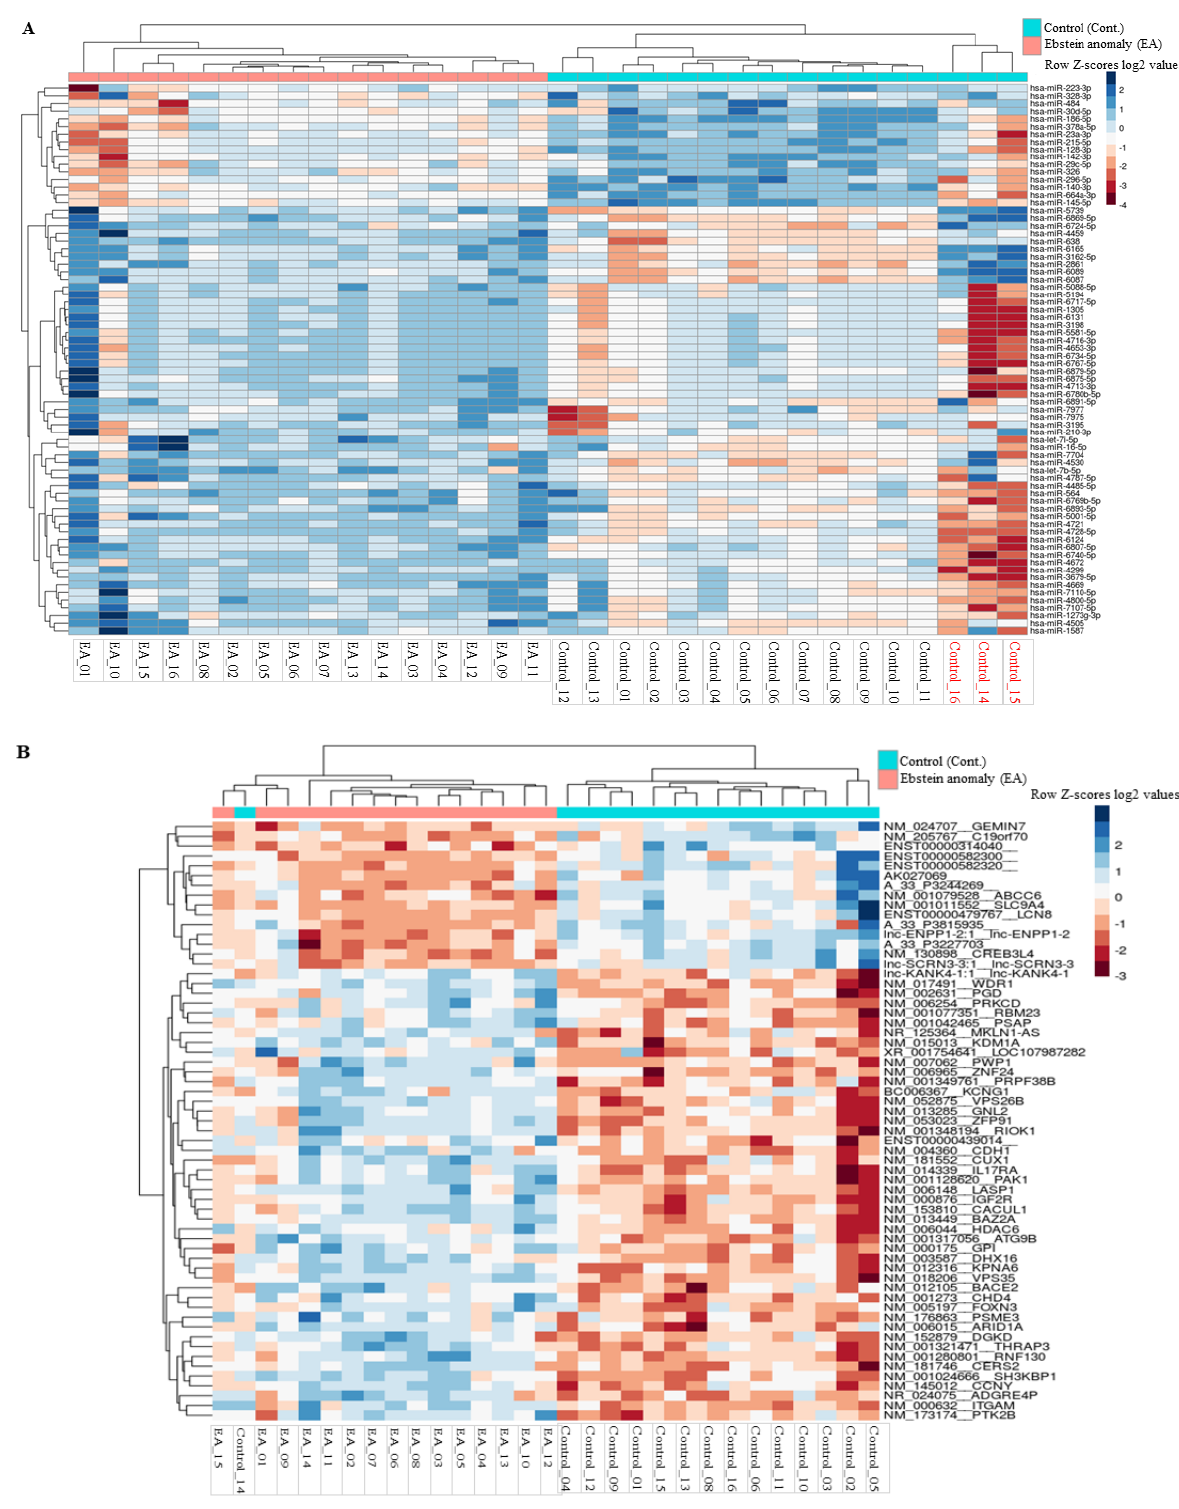
Figure 2. Unsupervised hierarchical clustering (Euclidian distance, complete linkage) of the patients with Ebstein’s Anomaly and Healthy controls based on the ( A ) differentially abundant miRNAs with significant highest variance out of 2549 miRNAs, ( B ) differentially abundant transcripts with significant highest variance out of 50,599 biological features. The heatmap shows miRNAs and transcripts with higher abundance levels in blue, miRNAs with lower abundance levels in red. The light blue and light red lines indicate the two clusters of samples, i.e., Ebstein’s Anomaly and Healthy